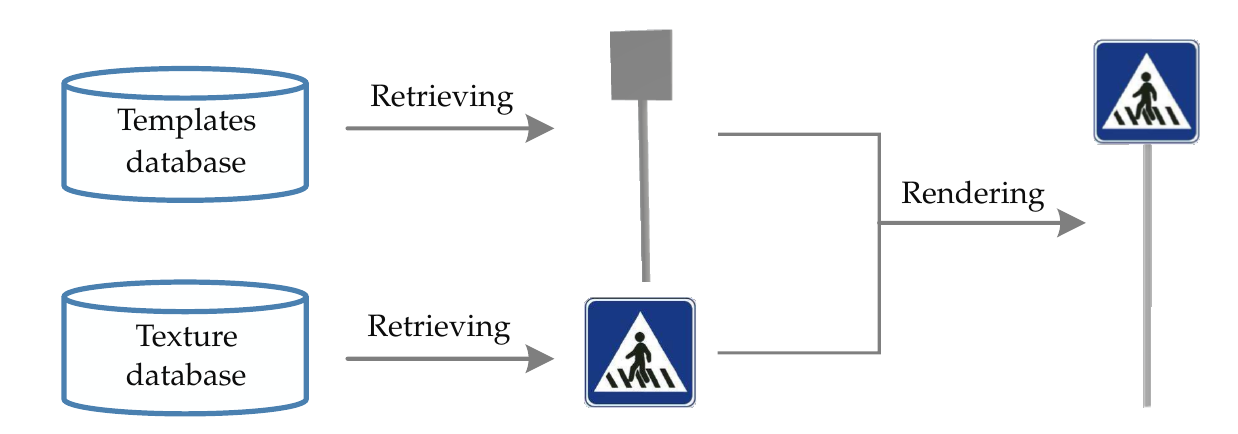
Figure 9. Schematic of road sign model generation.